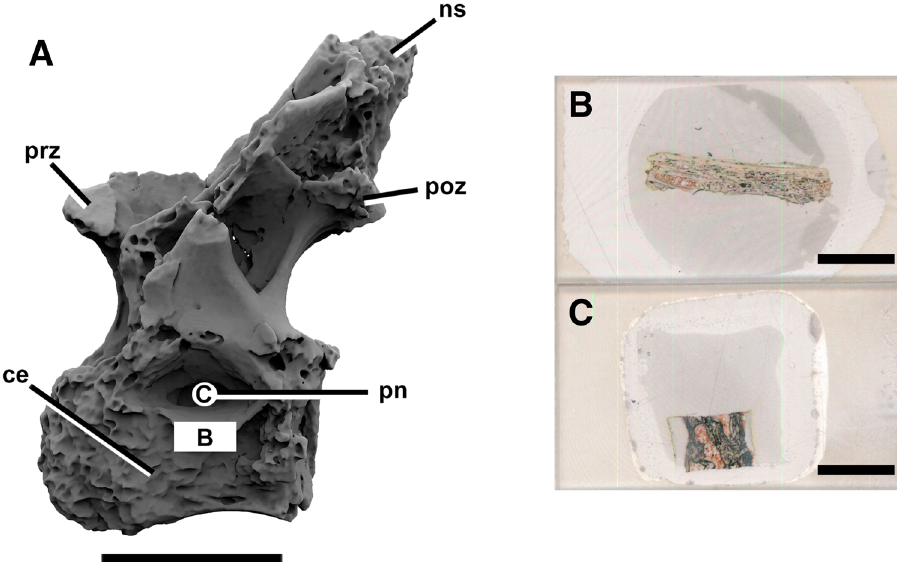
Figure 1. Posterior dorsal vertebra of the Upper Cretaceous nanoid saltasaurid LPP-PV-0200. Three- dimensional reconstruction from CT scan in left lateral view ( A ). Circle and rectangle show sampling planes and the respective thin sections are in ( B , C ). ce centrum, ns neural spine, pn pneumatopore, poz postzygaphophysis, prz prezygapophysis. Scale bar in ( A ) 10 cm; in ( B , C ) 1 cm. Computed tomography data processed with 3D Slicer version 4.10. Figures were generated with Adobe Photoshop CC version 22.5.1